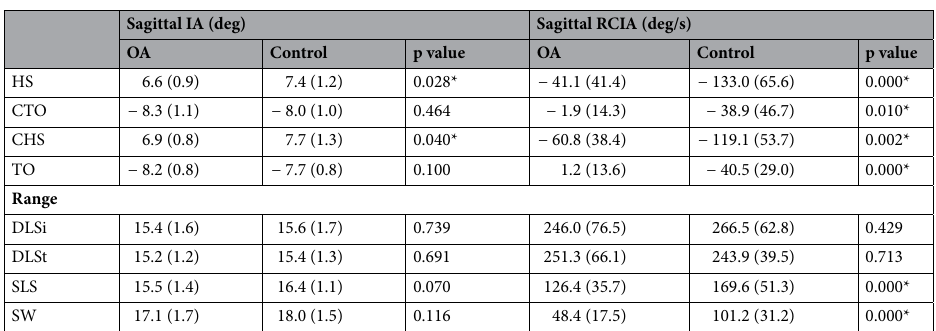
Table 3. Means (standard deviations) of the sagittal inclination angles (IA) and the rate of change of IA (RCIA) at heel-strike (HS), contralateral toe-off (CTO), contralateral heel-strike (CHS) and toe-off (TO), as well as average values and ranges of IAs during single-limb support (SLS), swing (SW), initial double-limb support (DLSi) and terminal double-limb support (DLSt). P-values for comparisons between knee OA and Control using independent t test are also shown. All significance levels were set at α = 0.05. *OA significantly different from Control.